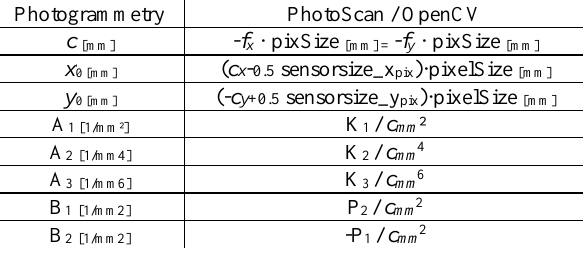
Table 1. Conversion scheme of interior orientation